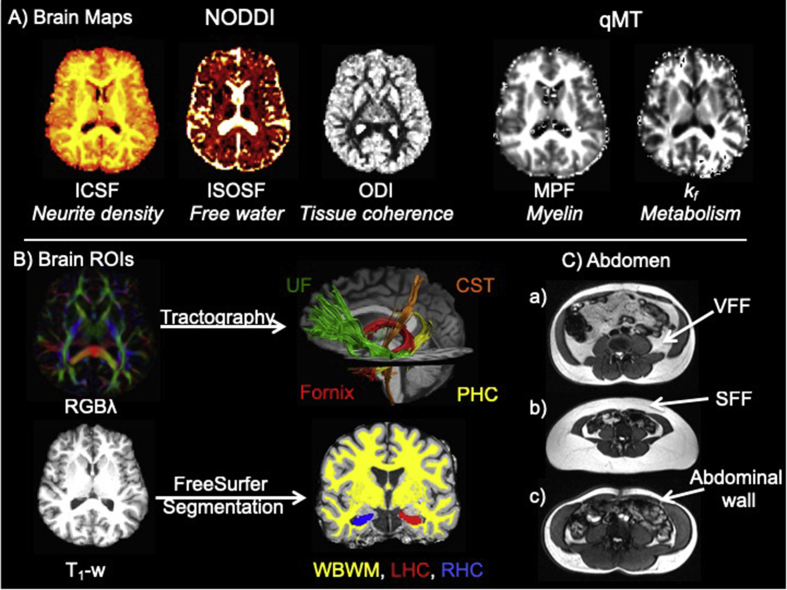
A) displays the MRI modalities and maps from dual-shell high angular resolution imaging (HARDI) and quantitative magnetization transfer (qMT) imaging. HARDI data were modelled with neurite orientation dispersion and density (NODDI) yielding maps of intracellular signal fraction (ICSF), isotropic signal fraction (ISOSF) and orientation density index (ODI). qMT based maps were the macromolecular proton fraction (MPF) and the forward exchange rate kf. B) Mean indices of the metrics were extracted from the left hippocampus (LHC) (red), right hippocampus (RHC) (blue), whole brain white matter (WBWM) mask (yellow), fornix (red), parahippocampal cinguli (PHC) (yellow), uncinate fasciculi (UF) (green) and corticospinal tract (CST) (orange). Hippocampi and WBWM were segmented from T1-weighted images with FreeSurfer version 5.3 and fornix, PHC, UF and CST were reconstructed with damped-Richardson Lucy spherical deconvolution (dRL) based deterministic tractography on colour coded principal direction maps (RGBλ). C) Examples of abdominal images from a) a 51 years old male with larger visceral (VFF) than subcutaneous fat area fraction (SFF), b) a 52 years old female with larger SFF than VFF and c) a 60 years old female with low SFF and VFF. All abdominal images were acquired with the same field of view of 480 × 390 mm.